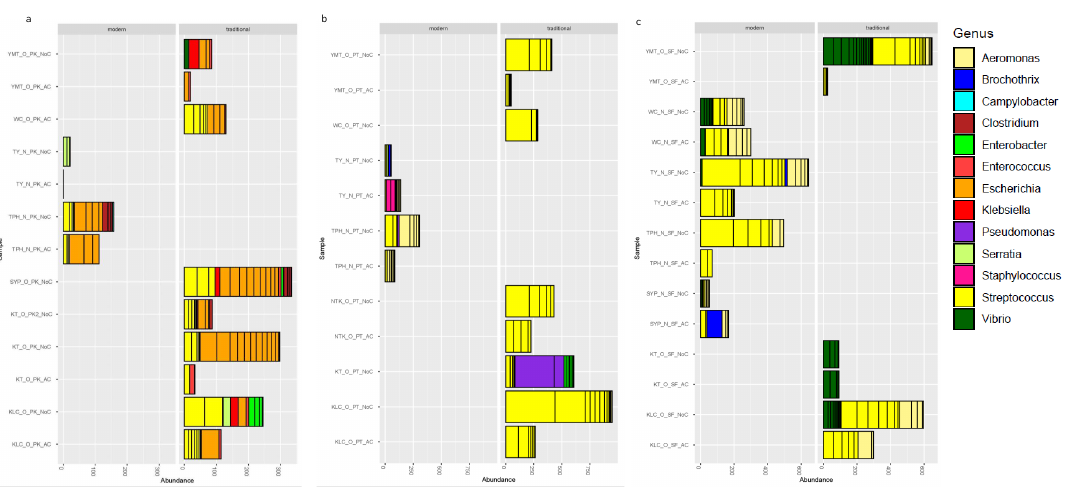
Figure 3. The relative genus-level abundance of bacteria in samples from wooden cutting boards used for di ff erent food groups: ( a ) pork, ( b ) poultry, and ( c ) seafood. Left (i) samples collected in modern wet markets. Right (ii) samples collected in traditional wet